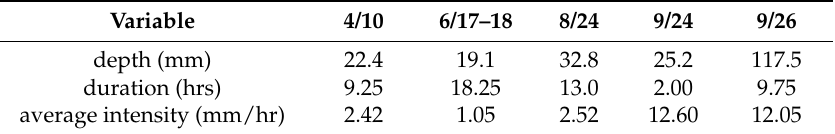
Table 1. Summary of precipitation events